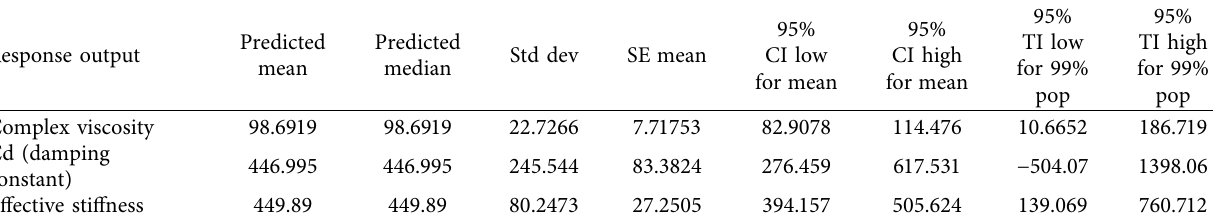
Figure 9: (a) Perturbation for efective stifness. (b) Contour graph for efective stifness. (c) Predicted vs. actual values for efective stifness. (d) 3D graph for efective Table 6: Point prediction of the response factors.